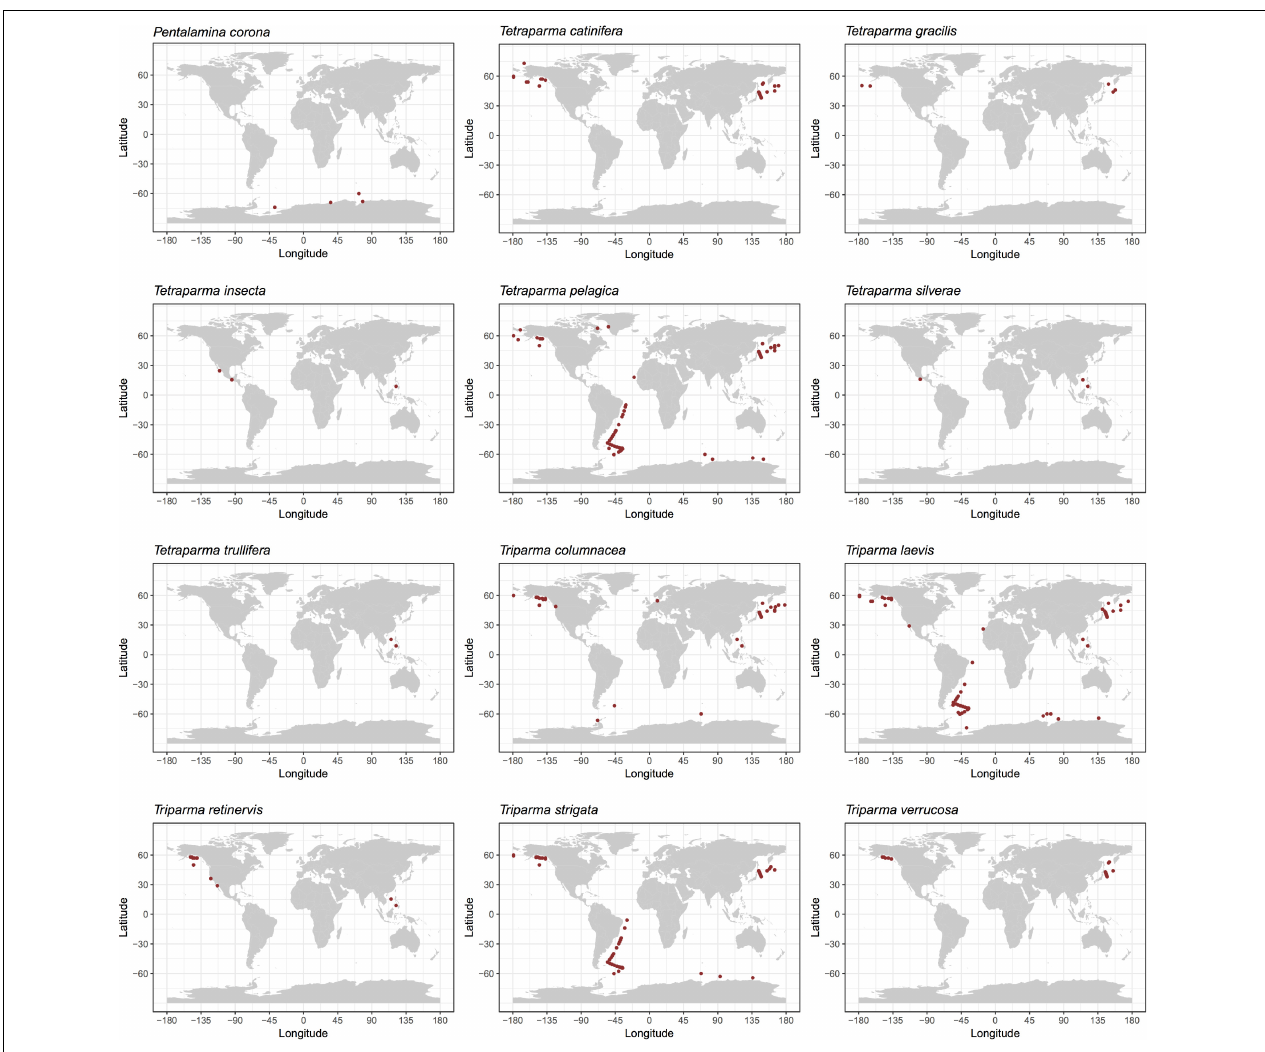
FIGURE 5 | Distribution of silicified Bolidophyceae species based on literature records of SEM observations (see Supplementary Table 1